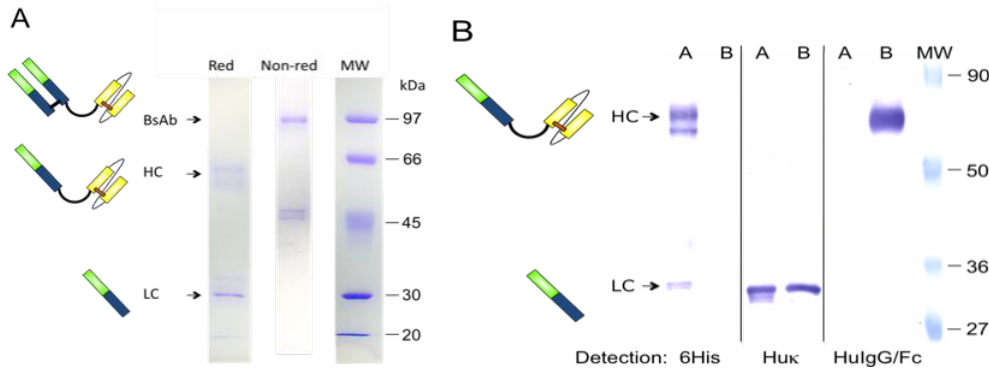
Figure 2. Biochemical analysis of bsAb. ( A ) Separation of purified bsAb by SDS PAGE under reducing (Red) and non-reducing (Non-red) conditions and stained with Coomassie Brilliant Blue. Lane MW contained the molecular weight marker. ( B ) Western blot analysis of bsAb in comparison to parental chiBCE19 mAb. Lane A; bsAb FabBCE19xdsFvT5.16; lane B; chiBCE19, MW; molecular weight standard. Immunoglobulin bands were detected by anti-hexahistidine, anti-human kappa chain and anti-human